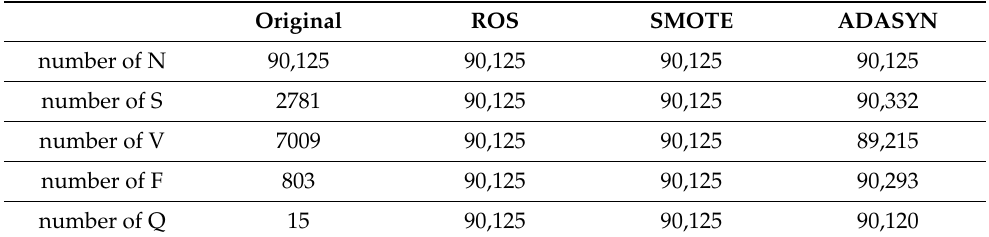
Figure 1. Plotting data of RR interval feature. Table 3. Distribution of heartbeats class in MIT-BIH